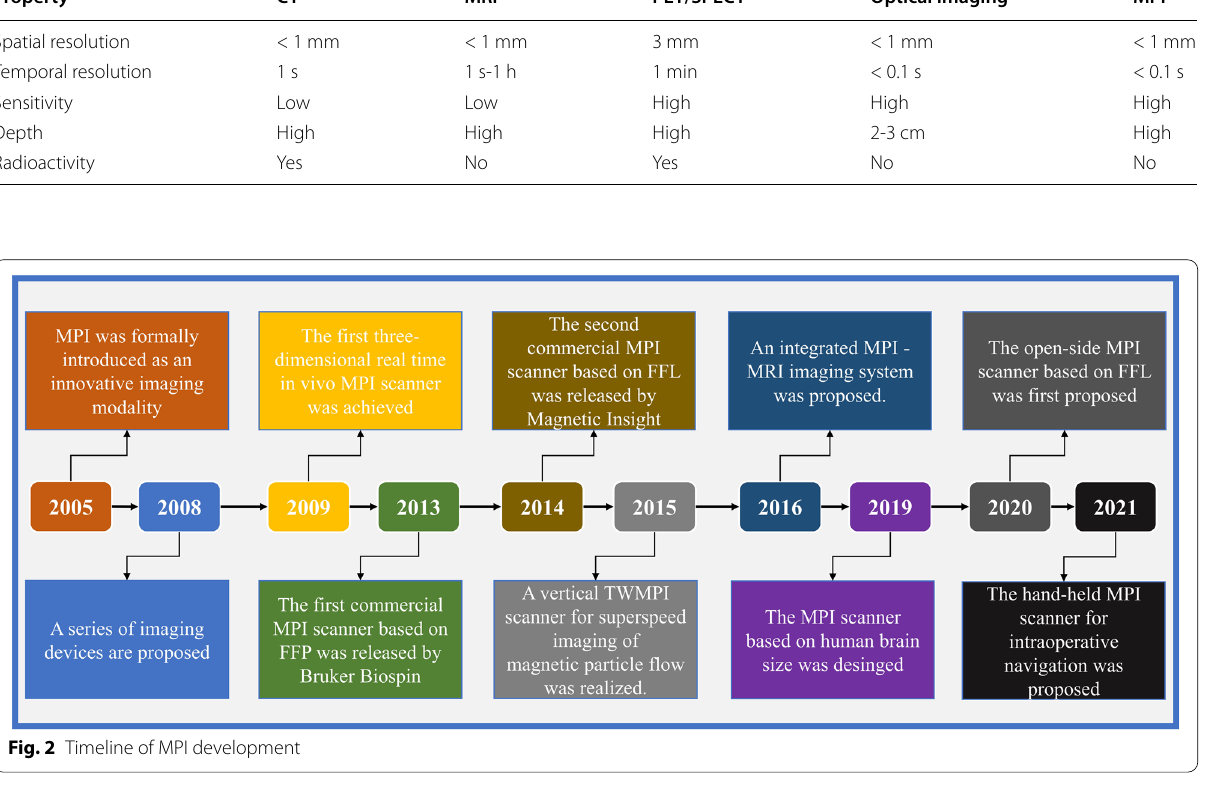
Fig. 2 Timeline of MPI